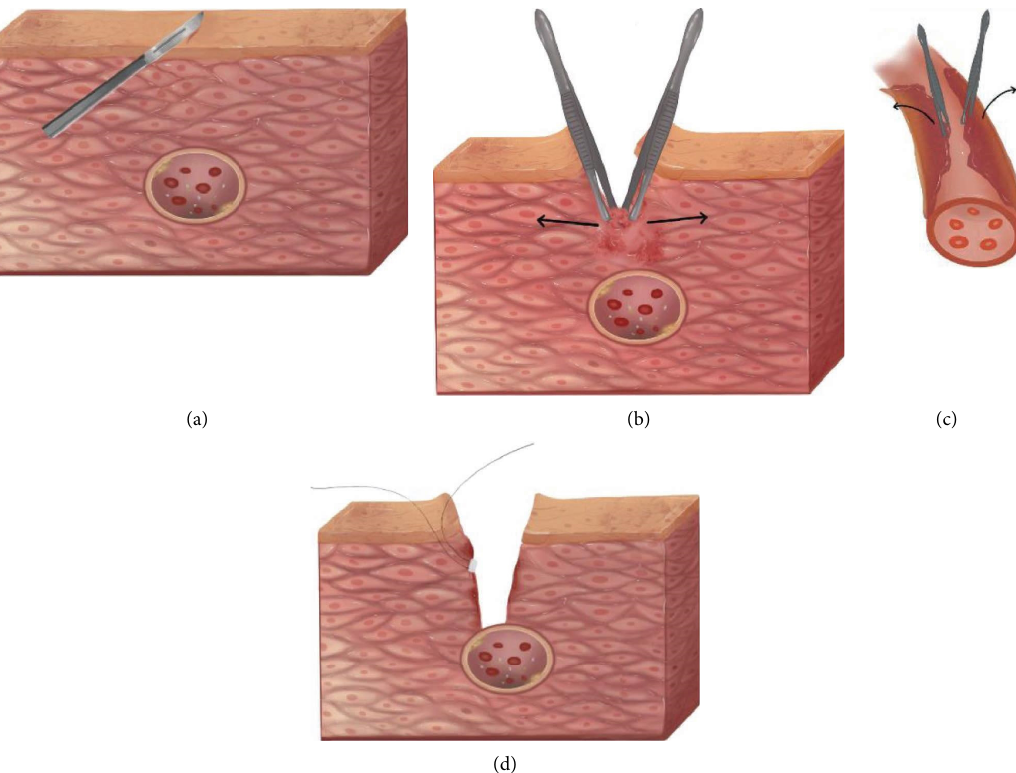
Figure 1: Schematic diagram of surgical unroofng using the blunt dissection technique. (a) Te epicardium overlying the LAD was divided by a Beaver blade; (b) all free coronary artery procedures were carried out using the blunt dissection method; (c) the blunt dissection method was used to divide the overlying tunica externa of MB; (d) a combination of Bovie cautery, clips, and suture ligation was used to control epicardial venous bleeding.